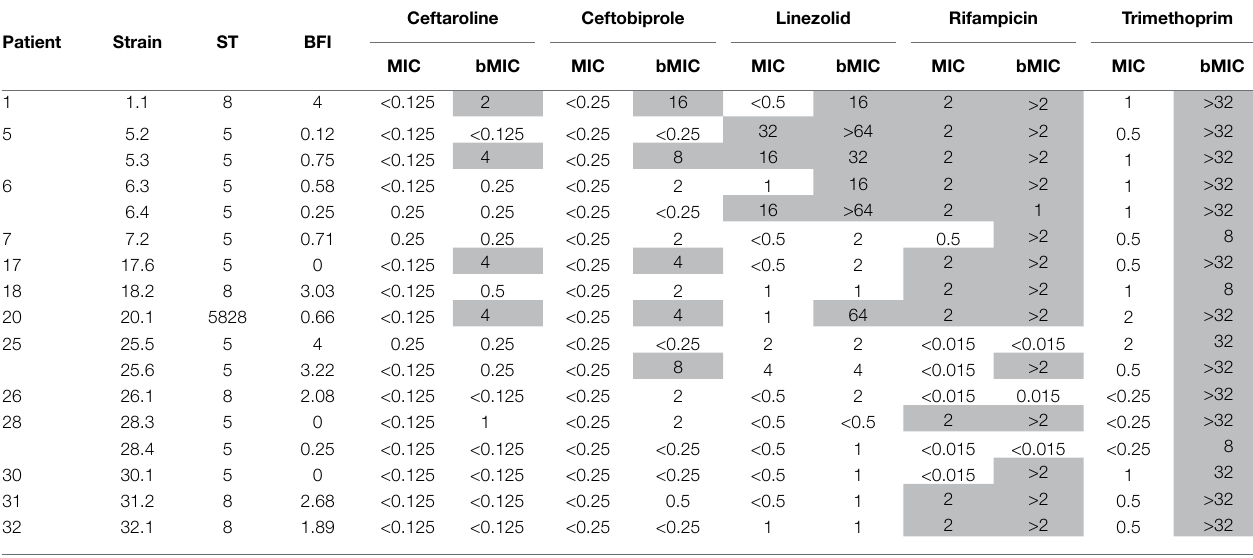
TABLE 2 | Detailed susceptibility results for the 17 CF MRSA strains that were classified as strongly adherent/strong biofilm producers according to the Biofilm Ring Test ® assay.